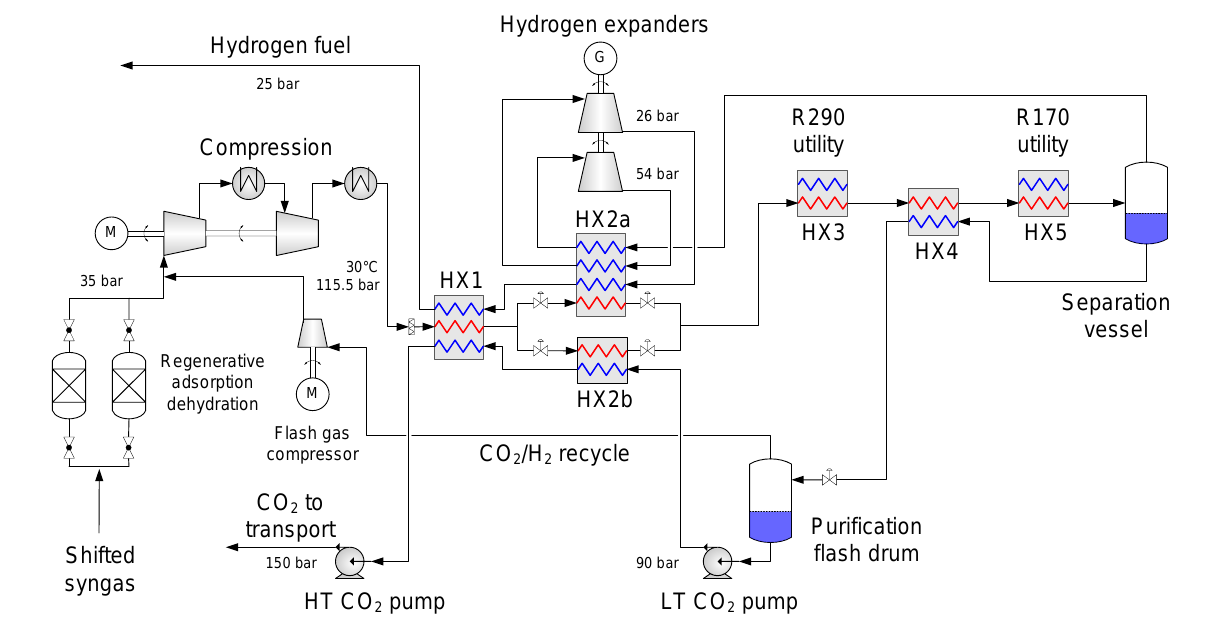
Figure 6. Baseline process design for the low-temperature CO 2 capture unit. After compression and aftercooling, the high-pressure synthesis gas enters the low- temperature heat exchanger network. In HX1, the stream is cooled by counter-flow heat exchange against the hydrogen-rich and CO 2 -rich separation products. The synthesis gas outlet temperature from HX1 is roughly − 8 ◦ C. At this point the stream is split into two branches with a split ratio close to 70:30 entering the parallel heat exchangers HX2a and HX2b. The largest branch is cooled and partially condensed in the four-stream heat exchanger HX2a, while the smallest branch is cooled against pressurised liquid CO 2 in HX2b. After passing through the parallel heat exchangers, the two stream branches, now partially condensed, are mixed and the resulting temperature is about − 36 ◦ C. The synthesis gas stream is further cooled and condensed in three heat exchangers in serial arrangement: to − 39 ◦ C in HX3, which is a propane (R290) evaporator where the cooling duty is provided by an auxiliary refrigeration cycle, further to − 43 ◦ C in HX4 by cooling against the cold, liquid CO 2 stream from the first separator, and to about − 56 ◦ C in HX5 in an ethane (R170) evaporator, which is also part of the auxiliary refrigeration cycle. The basic layout of the R290/R170 refrigeration cycle is provided in Section